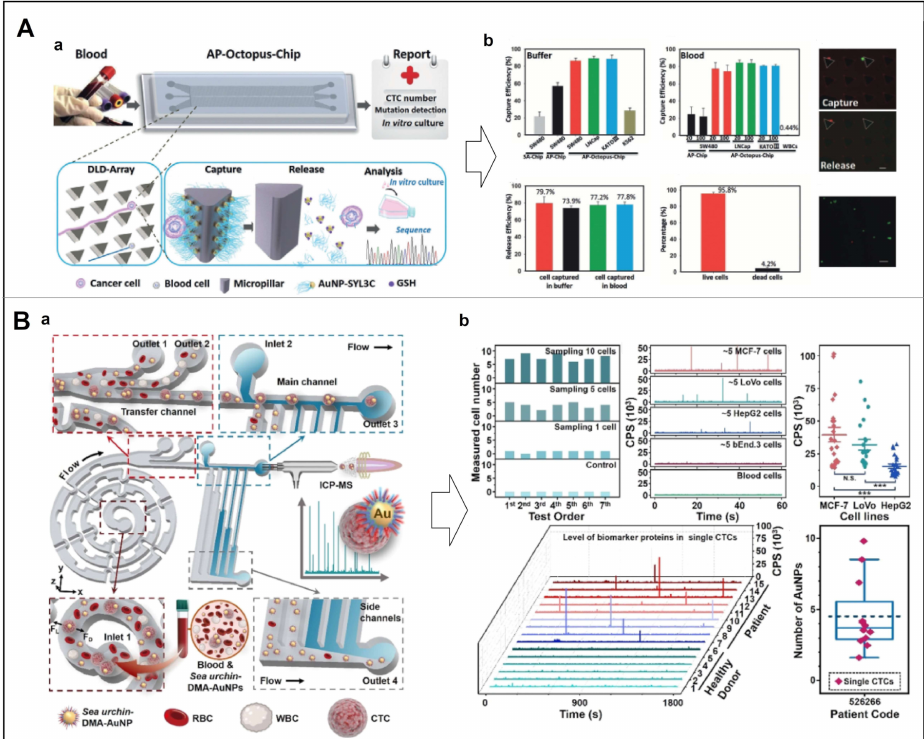
Figure 9. ( A ) Design of the NP-HBCTC-Chip for the capture and release of CTCs. ( a ) Based on the DLD principle, CTCs could continuously interact with aptamer-functionalized AuNPs in the channel; afterward, the captured CTCs could be released by the Au-S bond disrupted by excess GSH. ( b ) Capture performance in buffer and blood samples. Reproduced with permission from [82]. ( B ) Working principle of the AP-octopus-chip for CTCs recognition. ( a ) The CTCs captured by sea urchin-DMA-AuNPs were aligned and sorted in the microchip, then the captured CTCs were introduced to process efficient single-cell analysis. ( b ) Detection performance of the AP-octopus-chip, using different number of MCF-7 cells, various cell types from healthy and patients, respectively (N.S. for p > 0.05, *** for p < 0.00). Reproduced with permission from